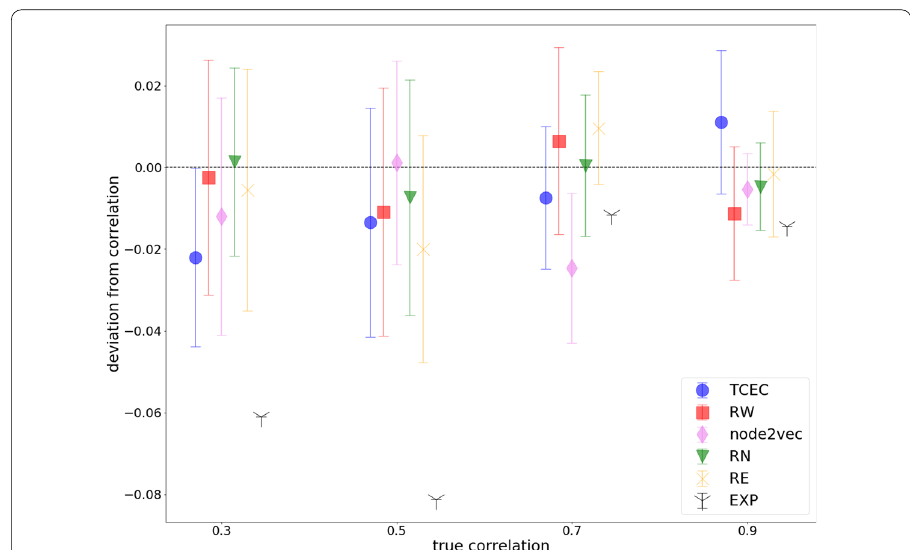
Fig. 4 Results from sampling SBM with varying levels of correlation between a binary covariate and the community membership. On the x-axis there is the ground truth correlation (the one used to generated the synthetic network). On the y-axis, we show the difference between this correlation and the one calculated after sampling. Standard deviations are computed over 10 different rounds of sampling 10% of all the nodes. Notice how the y-axis is restricted around the 0 values, denoting small deviations from the full network’s value. Notice that snowball sampling, being a deterministic method when starting from the same seed node (as in this experiment), presents no